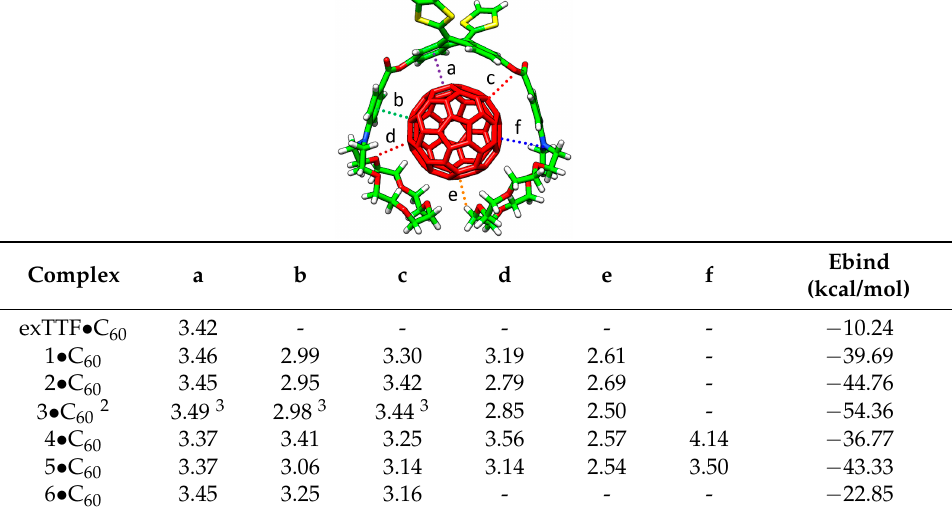
Complex Complex a b c d e f